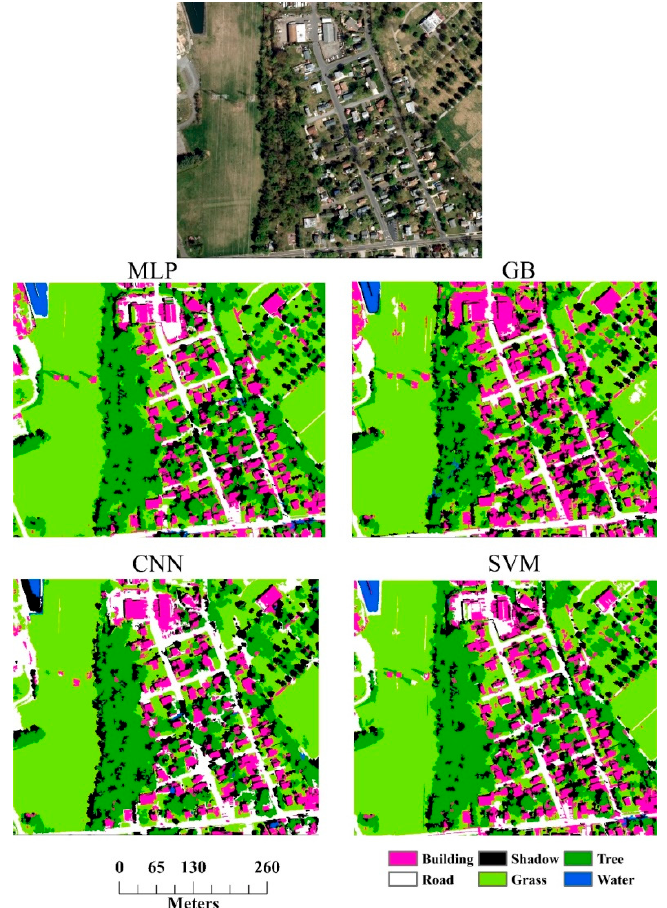
Figure 3. Subsets of classification maps generated by the regular deep multilayer perceptron (MLP), Gradient Boosting Trees (GB), convolutional neural network (CNN), and support vector machines (SVM) models generated for the 30 cm image.